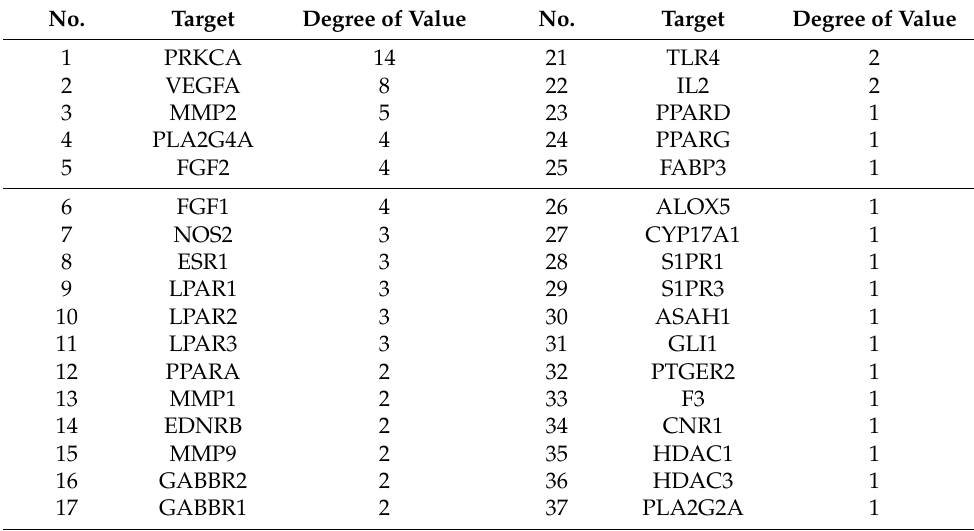
Figure 6. STC networks (122 nodes, 488 edges). Green rectangle: signaling pathway; gold triangle: targets; red circle: compounds. Table 5. The degree value of target in